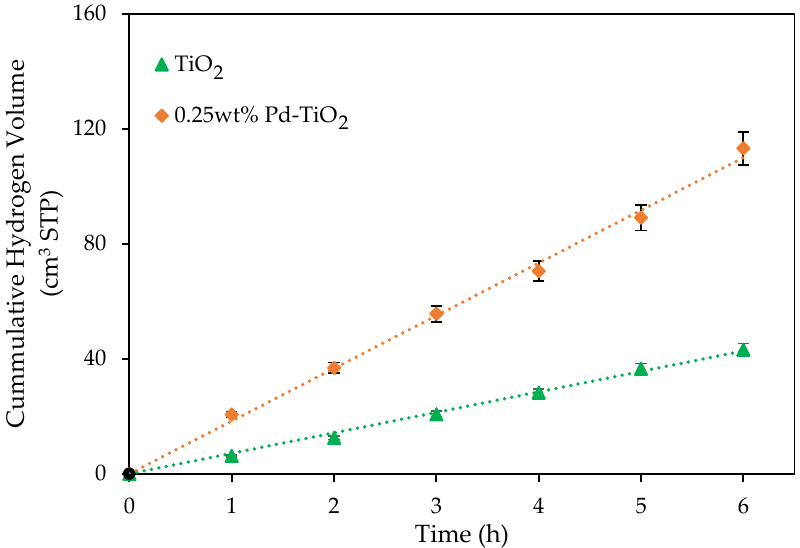
Figure 2. Cumulative hydrogen volumes produced using an undoped TiO 2 photocatalyst and a 0.25 wt% Pd-TiO 2 photocatalyst. Conditions: 0.15 g L −1 photocatalyst concentration; 2.0 v / v % ethanol; initial pH = 4 ± 0.05; 6 h under near-UV light. Note: at least three repeats were performed per experiment.